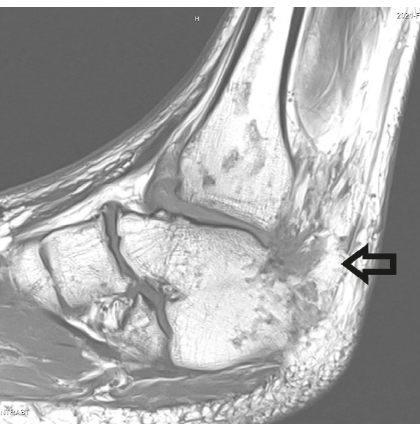
Figure 1: MRI of right ankle showing large complex tibiotalar joint effusion with synovitis and associated fluid collection along the flexor hallucis longus muscle belly (day 3 of hospitalization).